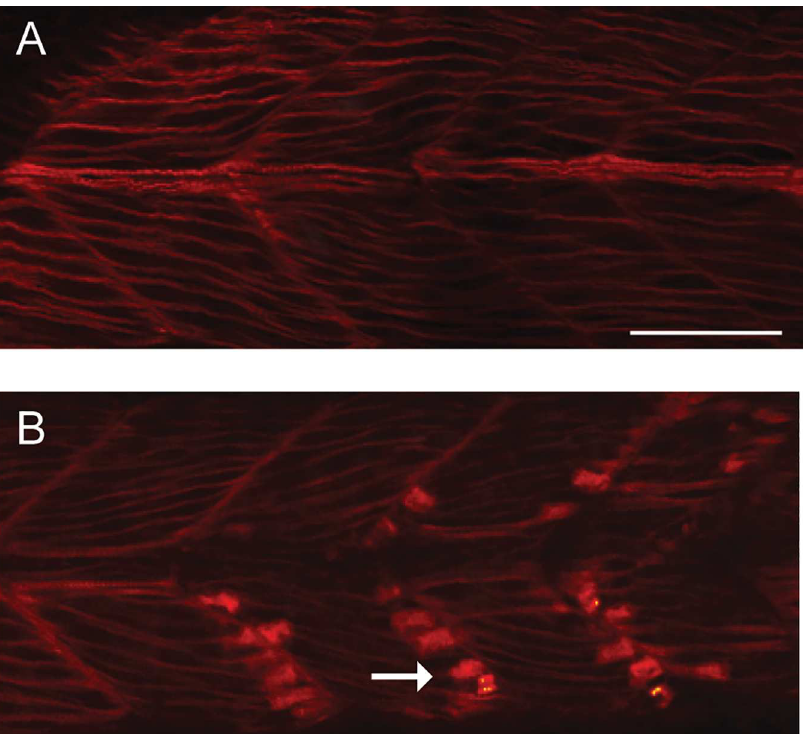
Fig 5. Abnormal phalloidin staining in skeletal muscle from caf mutant embryos. Wild type (WT) and caf mutants were stainingwith phalloidinto illuminatefilamentous actin and then visualizedwholemount by confocalmicroscopy. (A) WTs show the expectedpattern of stainingat 24 hpf (n = 5). (B) In muscle from caf mutants, there is an accumulationof intense stainingin the regionof the myotendinous junction (arrow) (n = 5). Scale bar = 10